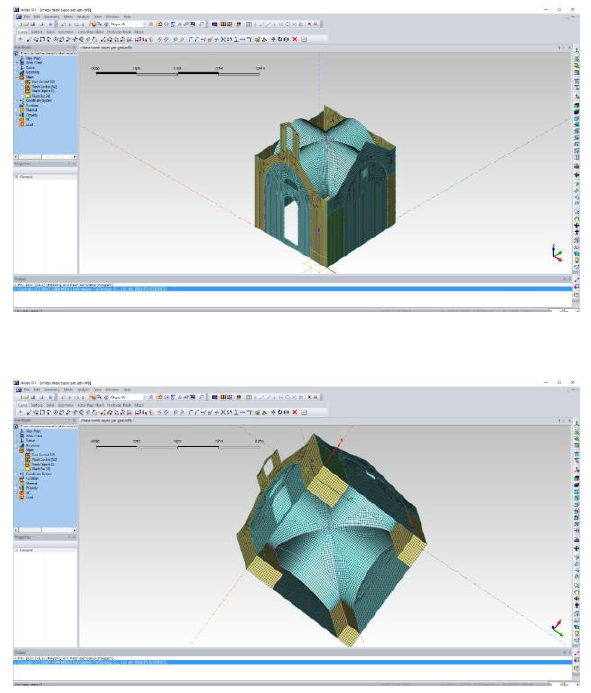
Figure 8. Mesh creation in